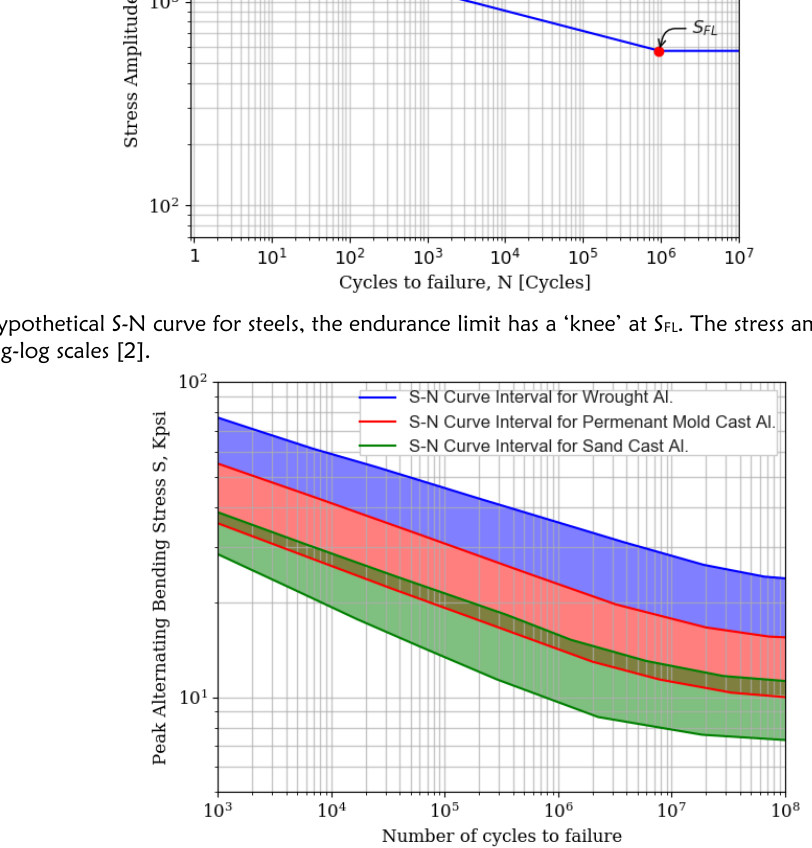
Figure 2b: Variation in S-N bands for aluminium alloy components subjected to different processing conditions